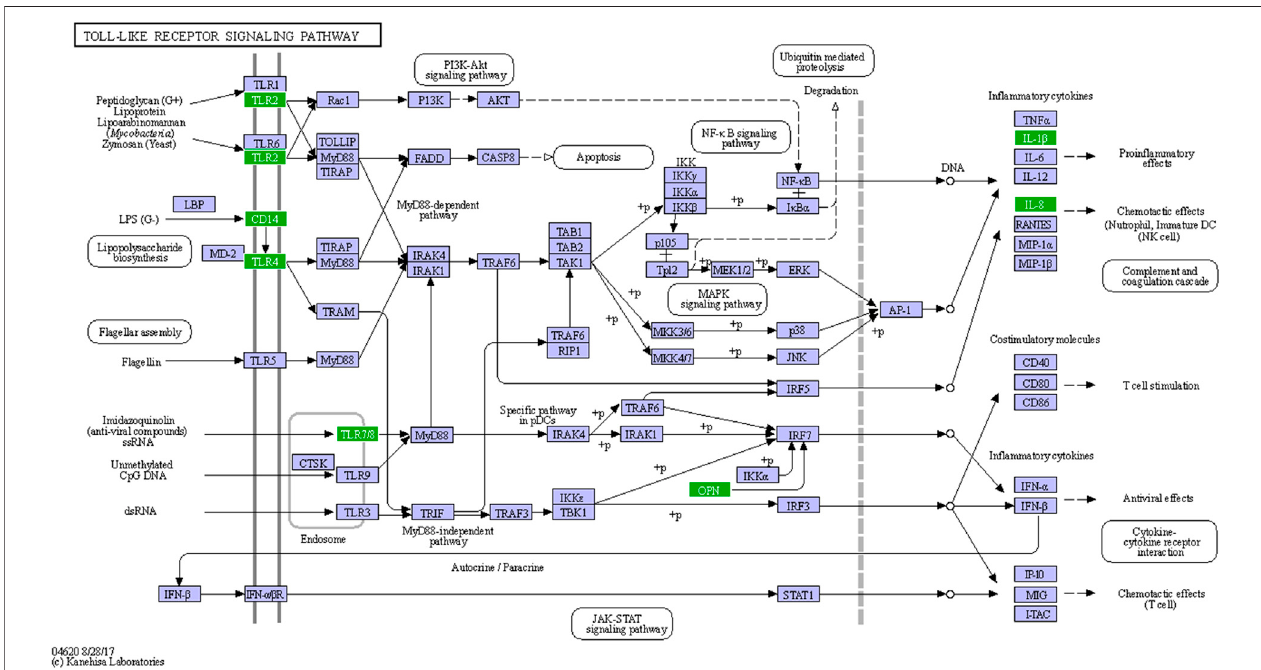
FIGURE 5 | Sensing of PAMPs through TLRs in LGMDD2 patients. Green coloured genes represent overexpressed genes in LGMDD2 patients.